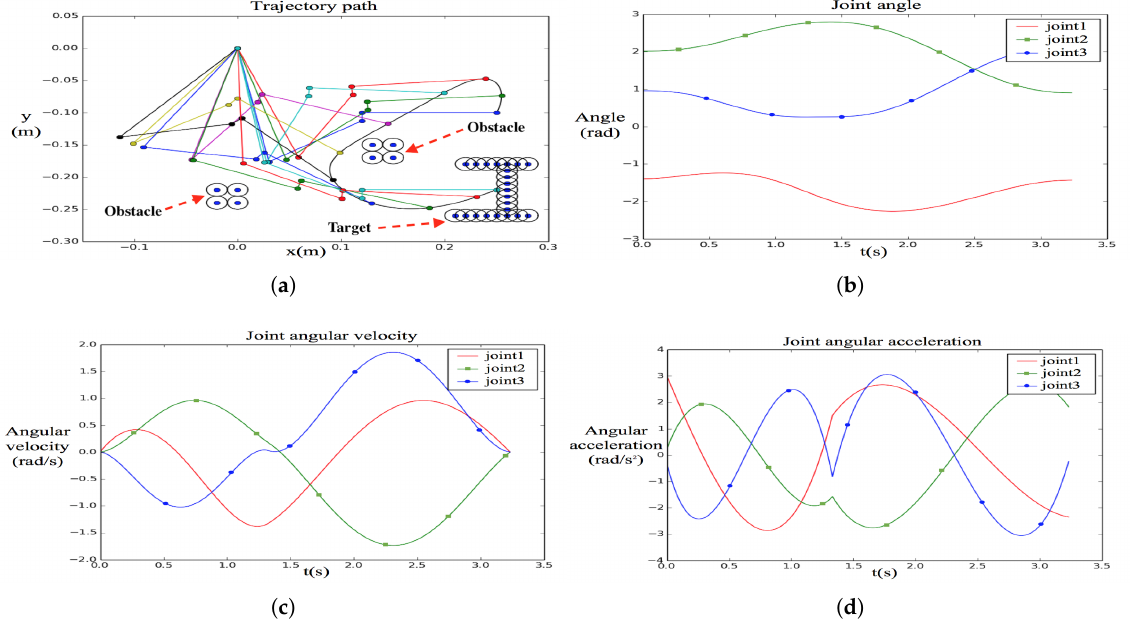
Figure 6. Planning results of our proposed trajectory planning algorithm. ( a ) Trajectory path; ( b ) joint angle; ( c ) joint angular velocity; ( d ) joint angular